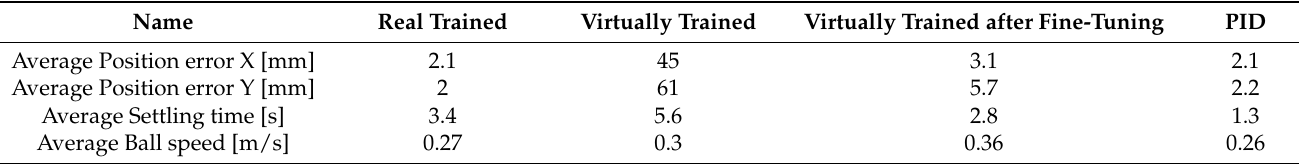
Table 3. Comparison of different training methods and